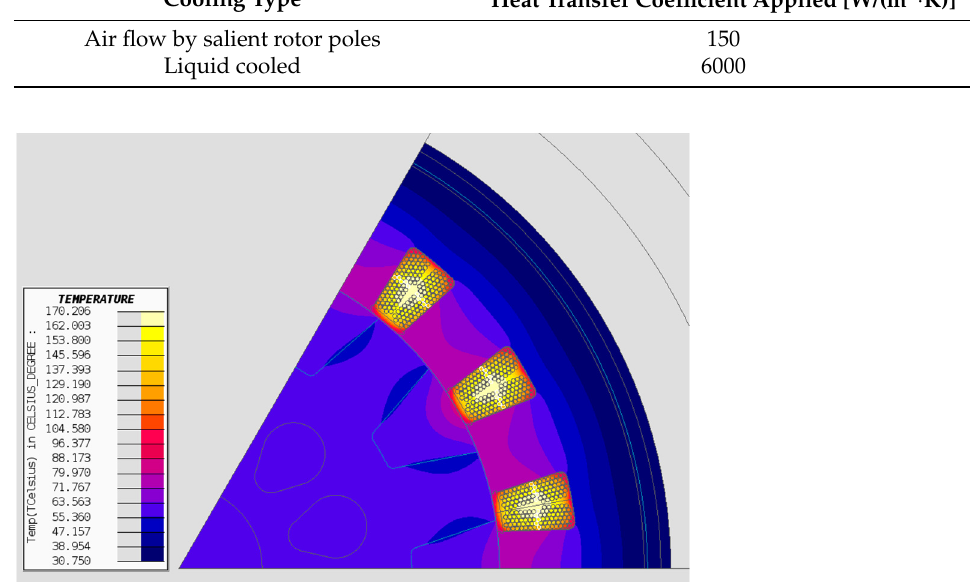
Figure 26. Steady-state thermal FEA result for LSA SRM at the base speed and maximum continuous power. Table 9. Heat Transfer Coefficients Guideline.